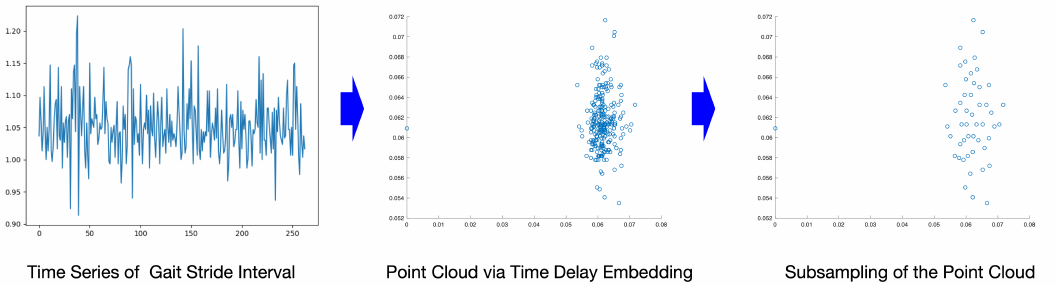
Figure 7. An illustration for time delay embedding subject HD #6 ( d = 2, τ = 5). Left: original stride interval time series (263 interval numbers). Middle: point cloud via time delay embedding (259-point cloud in the 2-D space). Right: subsampling of point cloud (50-point